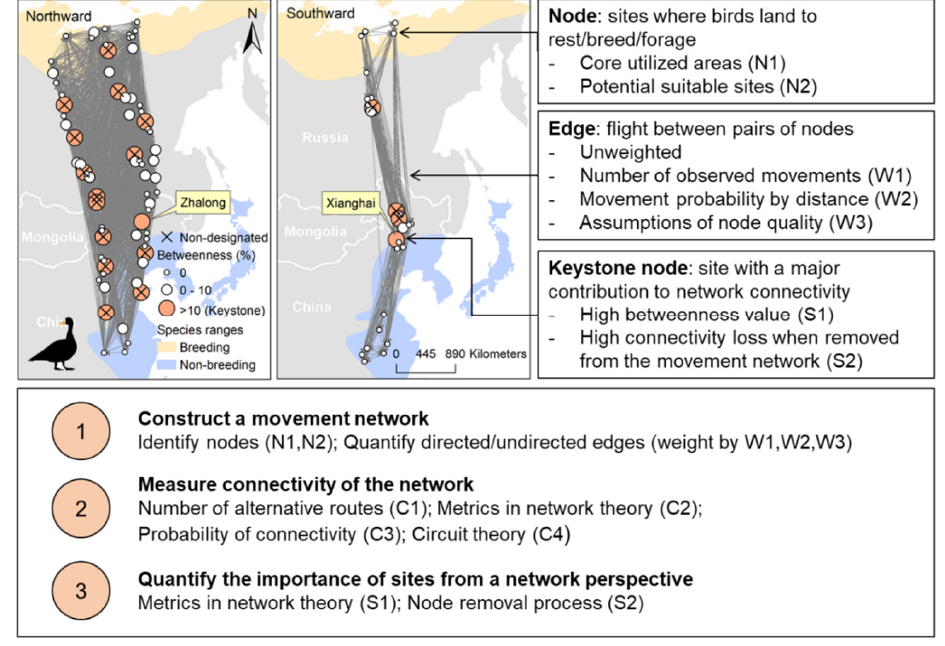
Figure 2. Main components and steps for the suggested approach for movement network conserva- tion. The example shown is a northward and southward migration network of Anser albifrons in East Asia, which was constructed on the basis of utilized core areas (N1) and movement probability (W2) with satellite tracking data (see [13] for details). The only protected keystone nodes are Zhalong and Xianghai National Nature